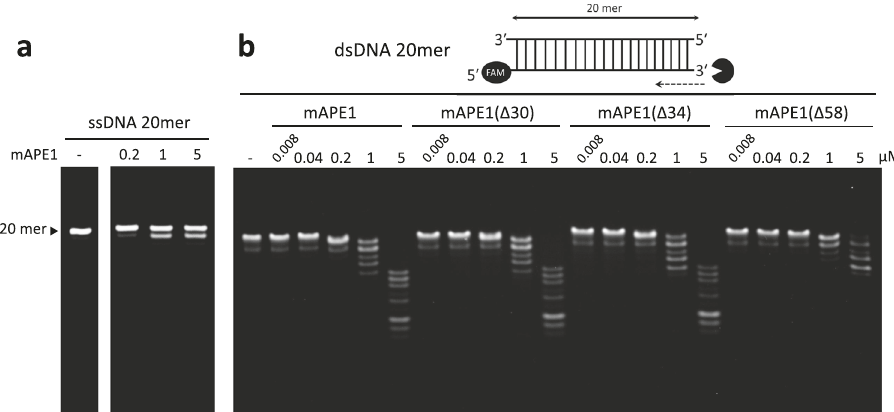
Fig. 1 Catalytic properties of mAPE1 in exonucleolytic cleavage. a , b Substrate preference of mAPE1 in digesting ssDNA and dsDNA. Higher activity in digesting dsDNA substrates is observed for mAPE1. The activities of full-length and truncated mAPE1 display similar activity levels toward dsDNA, except mAPE1( Δ 58) which shows a signi fi cant reduction in dsDNA degrading activity. a , b Source data are provided as a Source Data